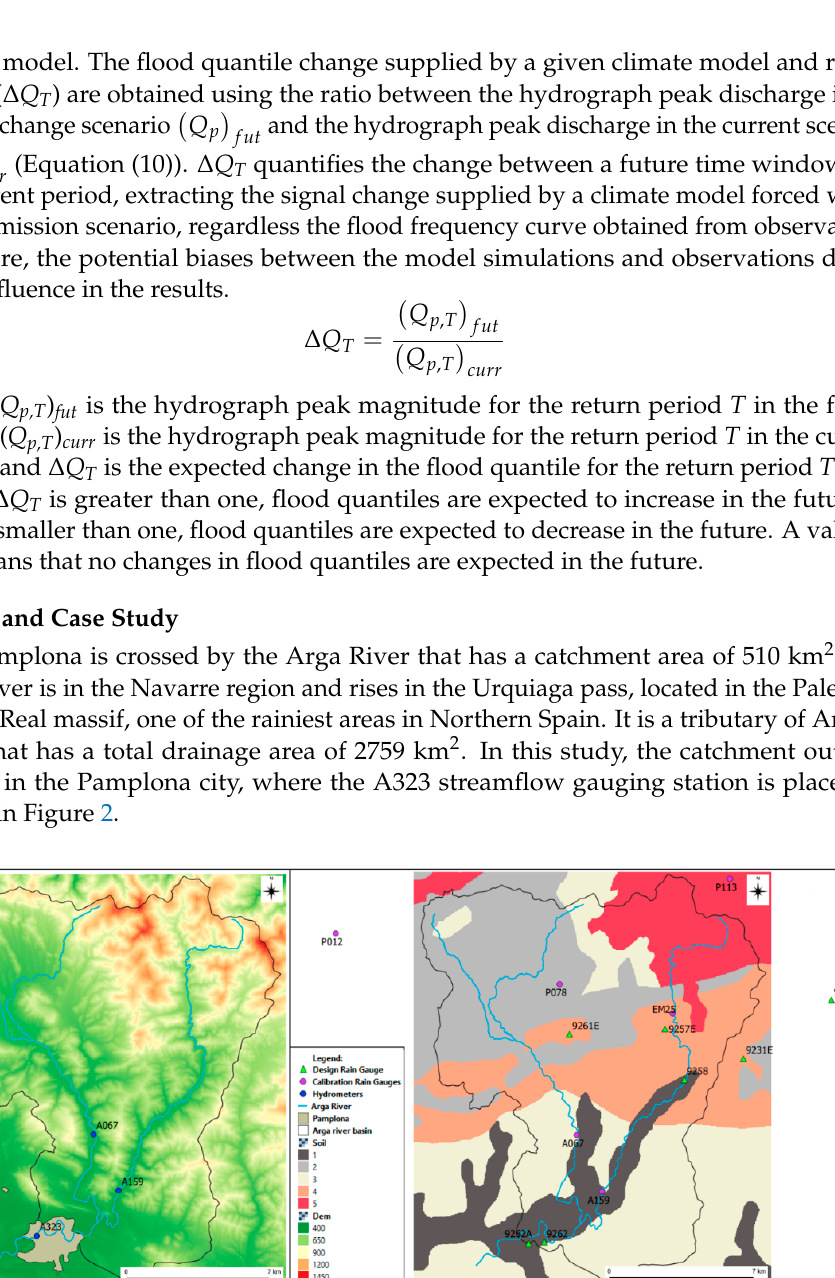
Table 2. Summary about the rain- and streamflow-gauge stations considered in the study.